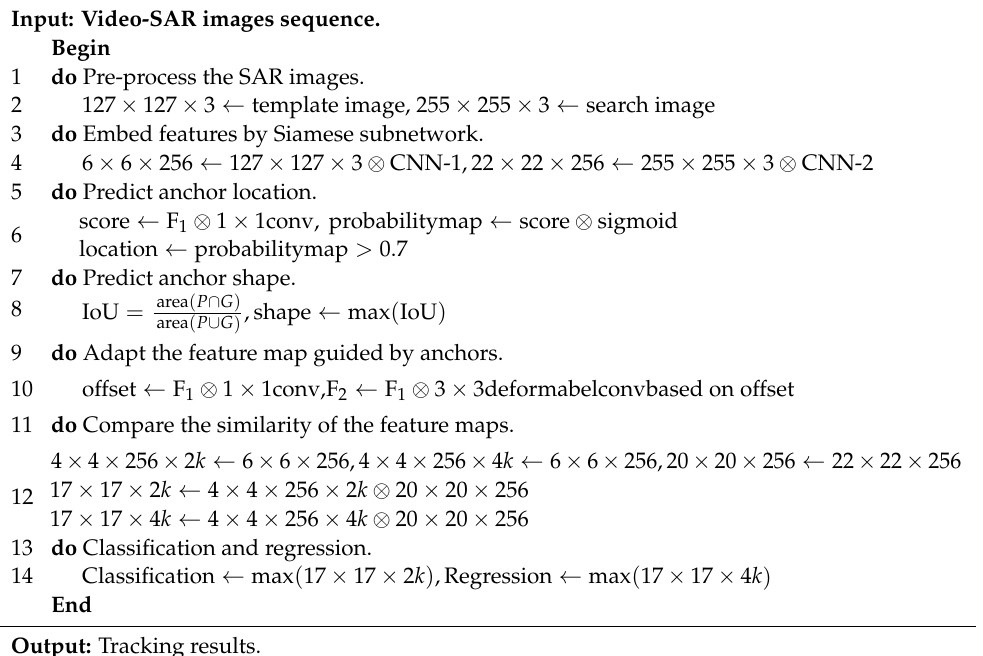
Algorithm 1: GASN tracks arbitrary TOI in